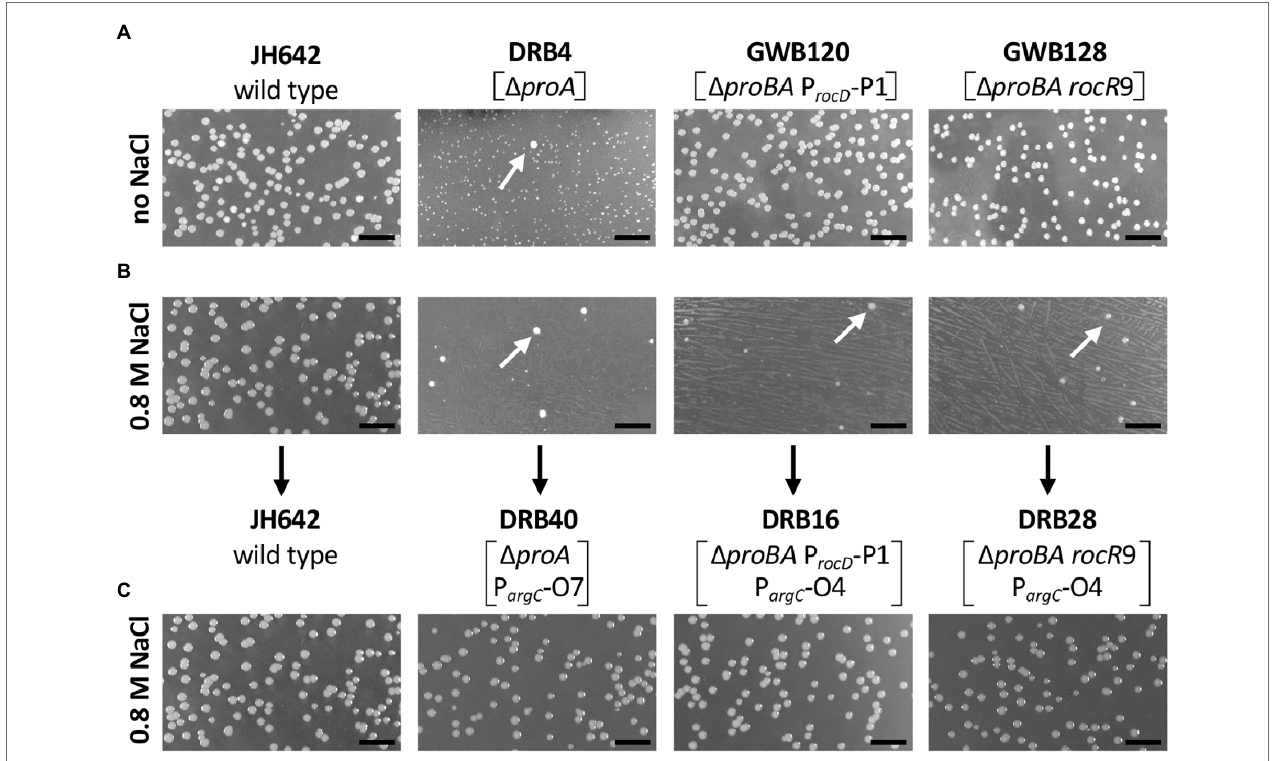
FIGURE 3 | Selection for osmostress resistant suppressor mutants bypassing a defect in the proA -encoded γ -glutamyl phosphate reductase. Equal dilutions of the indicated strains were plated onto either (A) SMM agar plates lacking L-proline or (B) SMM agar plates lacking L-proline but that contained 0.8 M NaCl. The plates were incubated for 72 h at 37 ° C. (C) Spontaneously arising faster growing suppressor colonies (indicated by the white arrows) were picked from the high-salinity agar plates, purified by streaking single colonies on the same medium, and dilution of liquid cultures were replated onto the high-salinity L-proline-free agar plates. The length bar corresponds to 5 mm. Bacillus subtilis JH642 is the wild-type strain (Smith et al., 2014) from which the first generation suppressor strains DRB4, GWB120 and GWB128 were derived (Zaprasis et al., 2013b). Strain DRB4 and its derivatives contain a deletion of the proA gene but proB is intact. In strains GWB120 and GWB128, the entire proBA operon is deleted but ProB enzyme activity is provided in these strains via the amino acid sequence related ProJ L-glutamate kinase; hence these strains are not L-proline auxotrophs (Belitsky et al., 2001; Brill et al., 2011a; Zaprasis et al., 2013b). Strains GWB120 and GWB128, carry mutations either in the regulatory region of the rocDEF operon, or in the gene for the RocR activator protein; both mutations increase rocDEF expression (Zaprasis et al.,